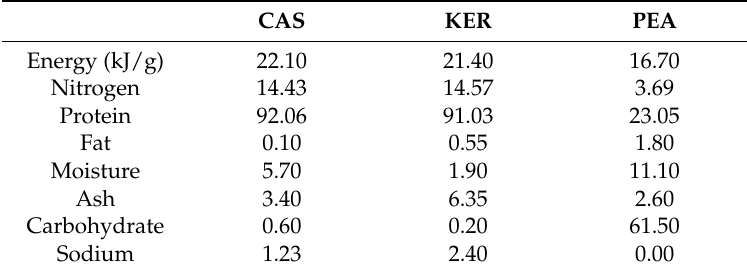
Table 1. Analysis of sources of dietary protein: sodium caseinate (CAS), keratin (KER), and yellow pea flour (PEA). Data are shown in g/kg, except for